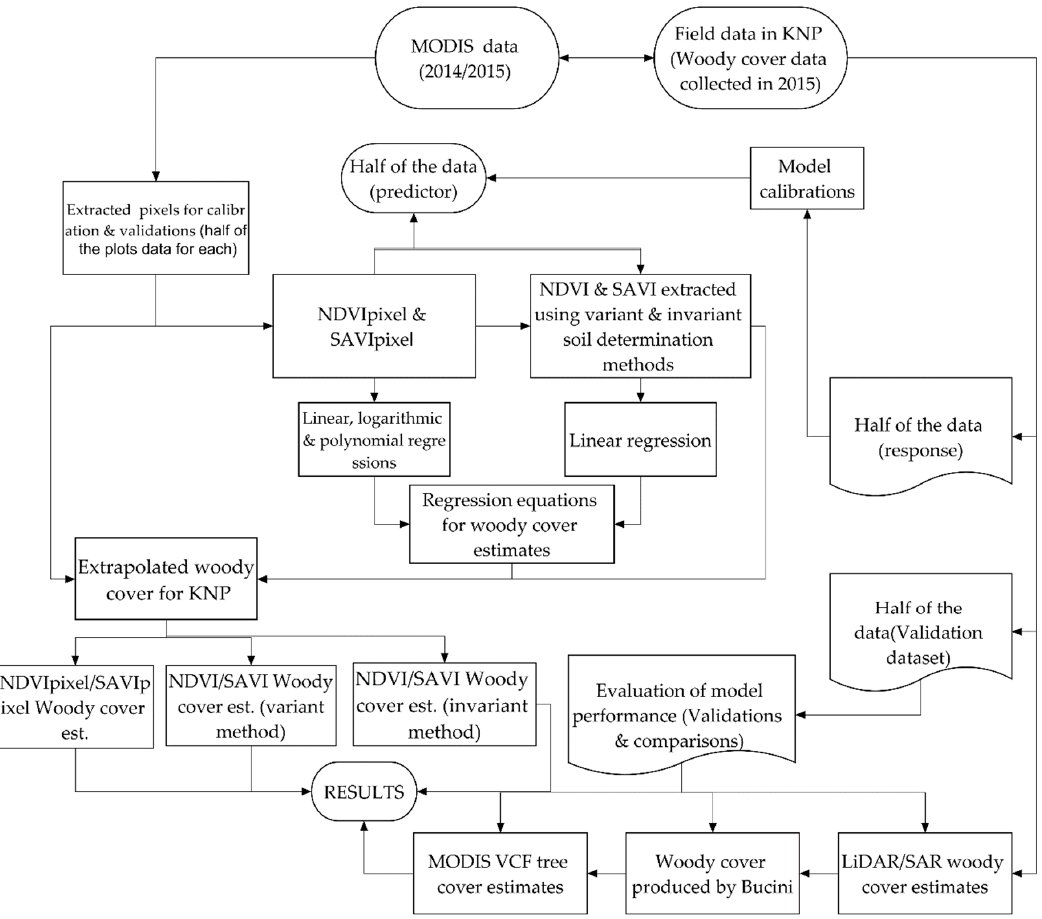
Figure 3. Flowchart showing data sets and processing procedure for the estimates of woody cover in KNP.